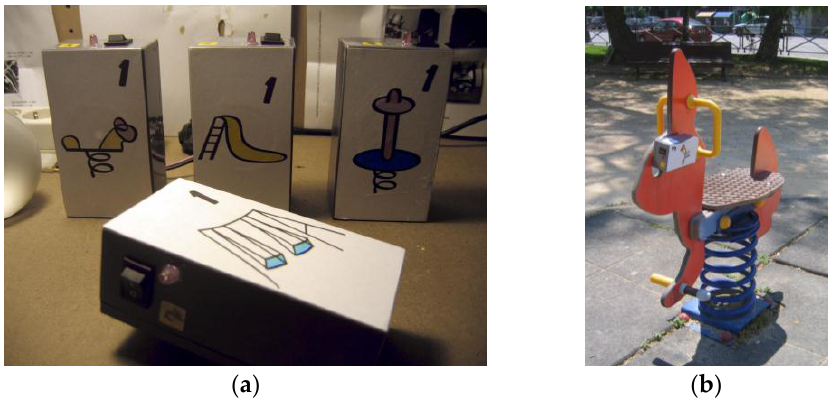
Figure 3. First version of the sensor. ( a ) The different models, according to the elements of the playground; ( b ) one of the sensors attached to the hobbyhorse.